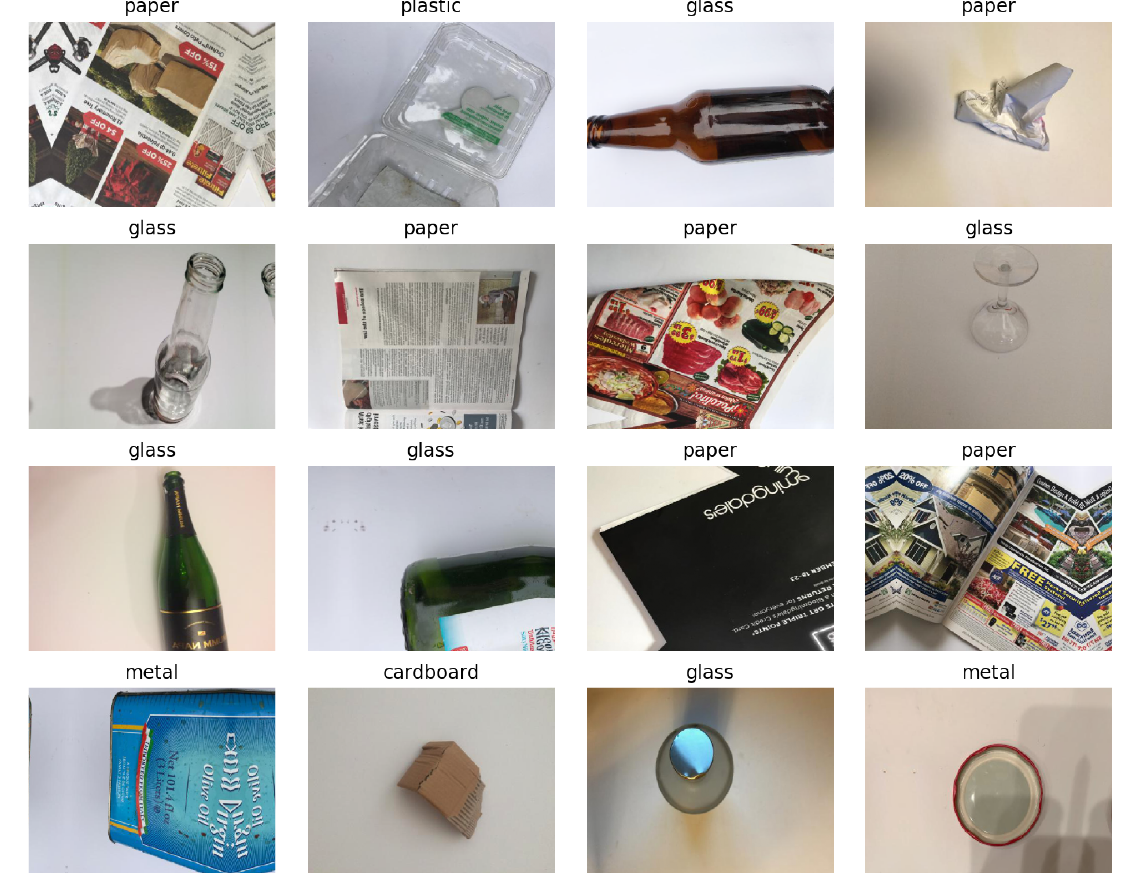
Figure 2. Illustration of TrashNet data from different